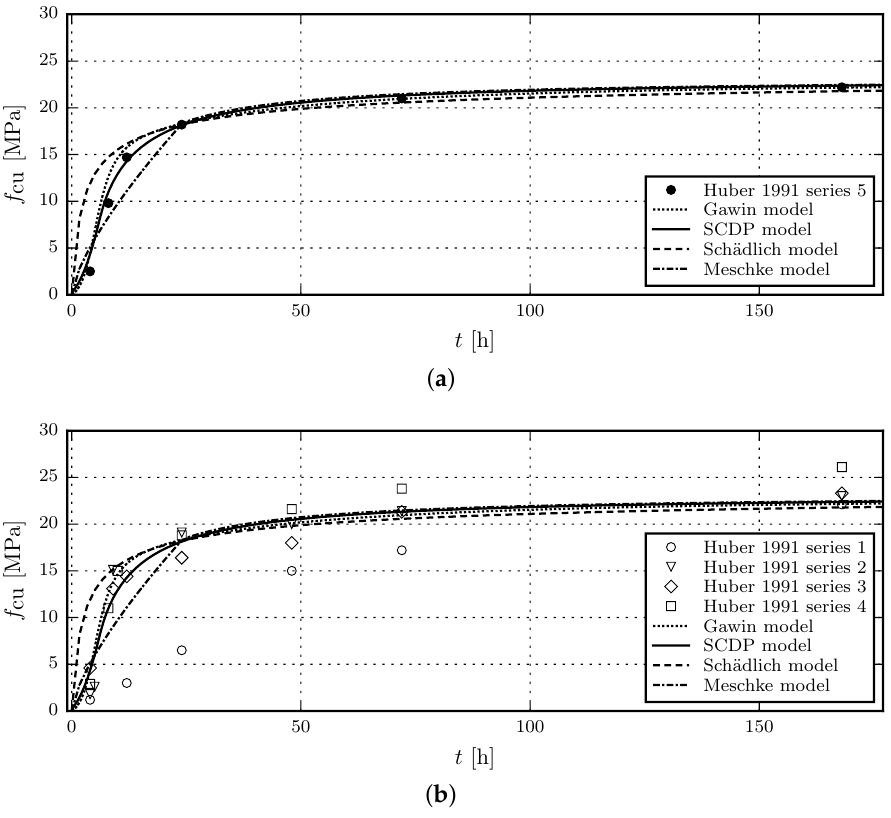
Figure 3. Evolution of the uniaxial compressive strength: ( a ) Results of the calibration of the shotcrete models based on test data of test series 5 by Huber [15]; ( b ) Validation of the shotcrete models by means of the data of test series 1 to 4 in [15].